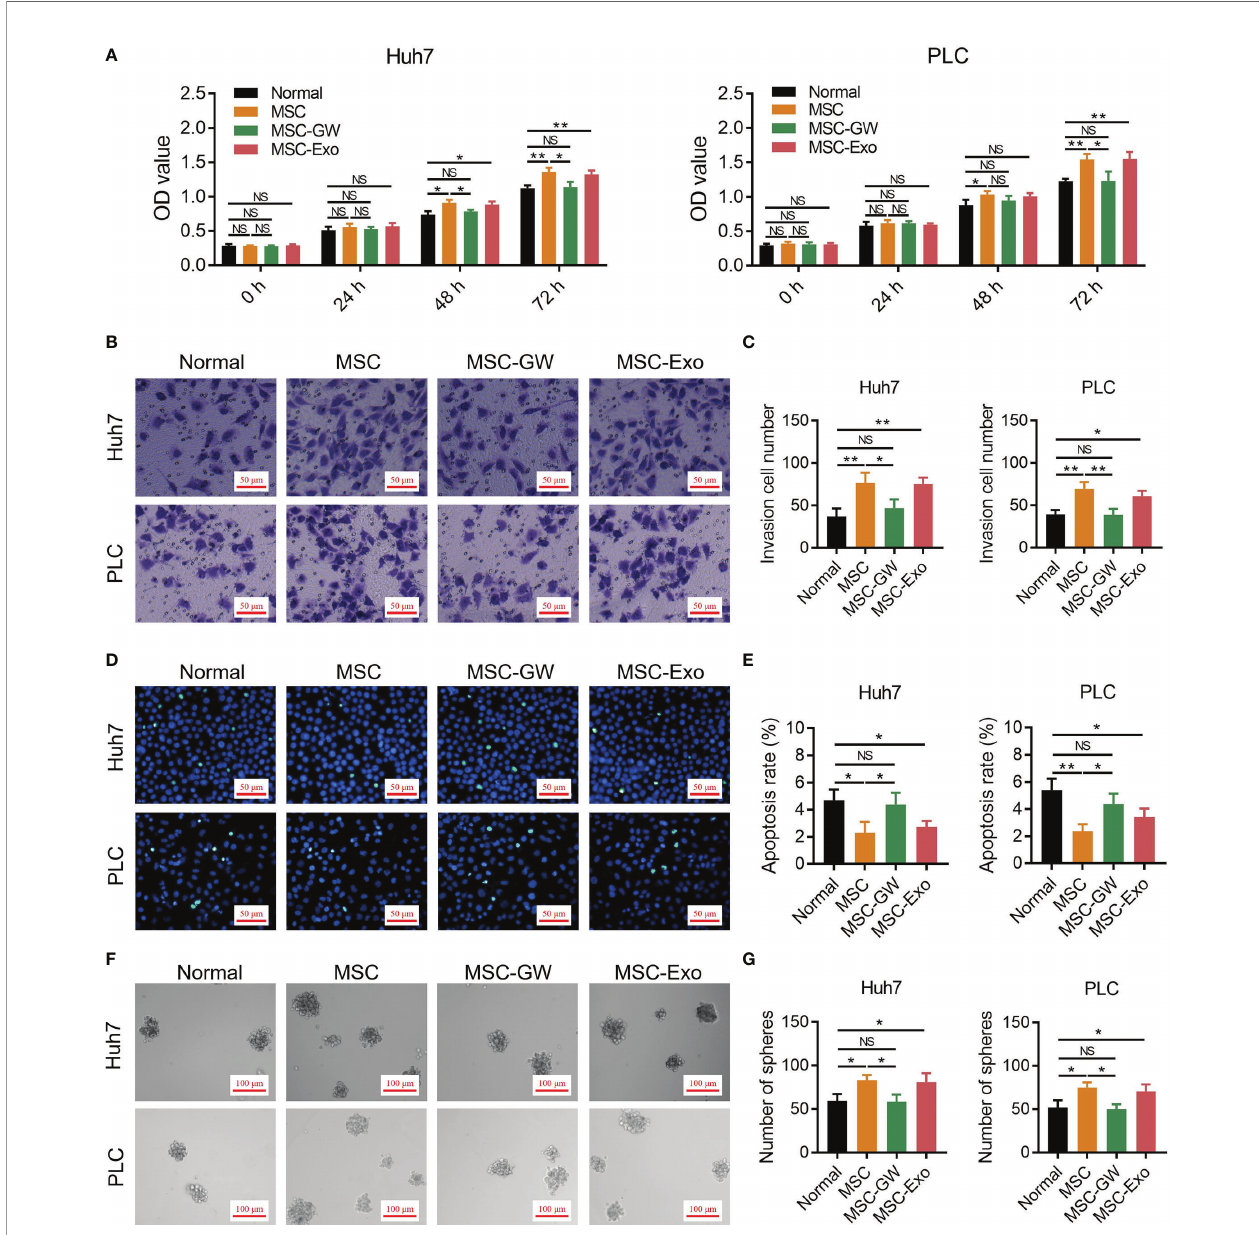
FIGURE 1 | Effect of HCC-MSCs and their derived exosomes on HCC cellular functions. Comparison of viability (A) , invasion (B, C) , sphere formation ability (D, E) , and apoptosis (F, G) among groups in Huh7 and PLC cells. HCC cells were cultured normally or co-incubated by HCC-MSCs, HCC-MSCs with GW4869 treatment, or exosomes of HCC-MSCs. Purple cells indicate invaded cells in panel (B) Green cells indicate apoptotic cells in panel (D) NS, not signi fi cant; * p < 0.05; ** p < 0.01. HCC, hepatocellular carcinoma; MSCs, mesenchymal stem